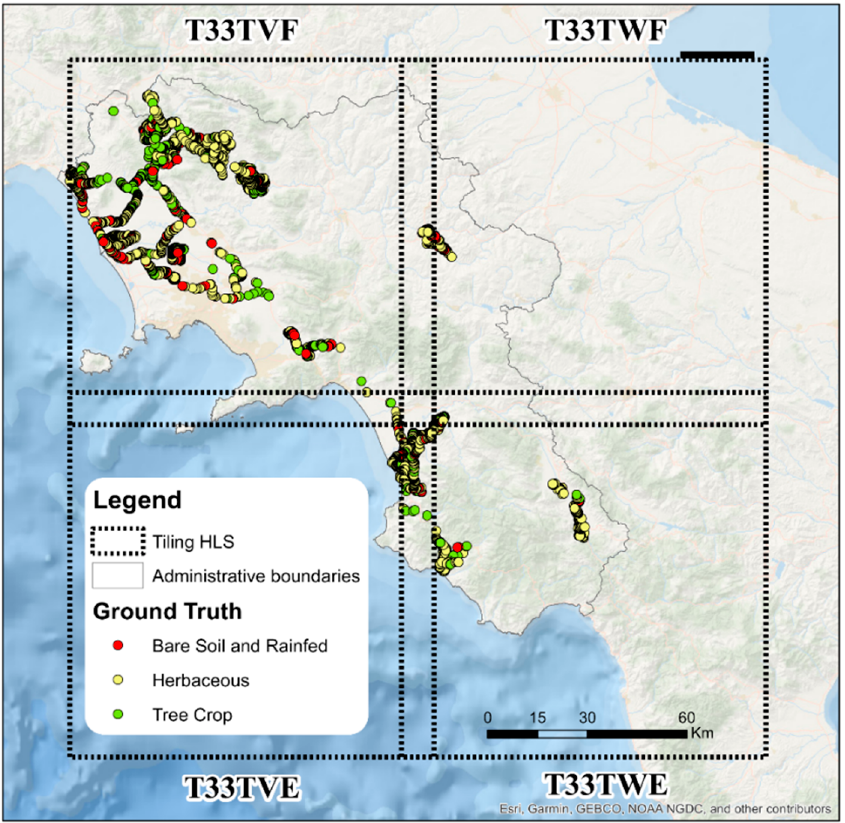
Figure 1. The four tiles on Campania region from Harmonized Landsat Sentinel-2 (HLS) products that we considered in this work. Colored points represent ground truth samples that will be further described in Figures 7 and 8. Table 1. Summary of the Harmonized Landsat Sentinel-2 (HLS) data selection process. (a) Number of initial images spanning year 2018. (b) Number of images after removing data covered by clouds or marginally overlapping (<20%) with the area of interest. (c) Number of final images used in the analysis in addition with the revisit time (in days) for each tile.